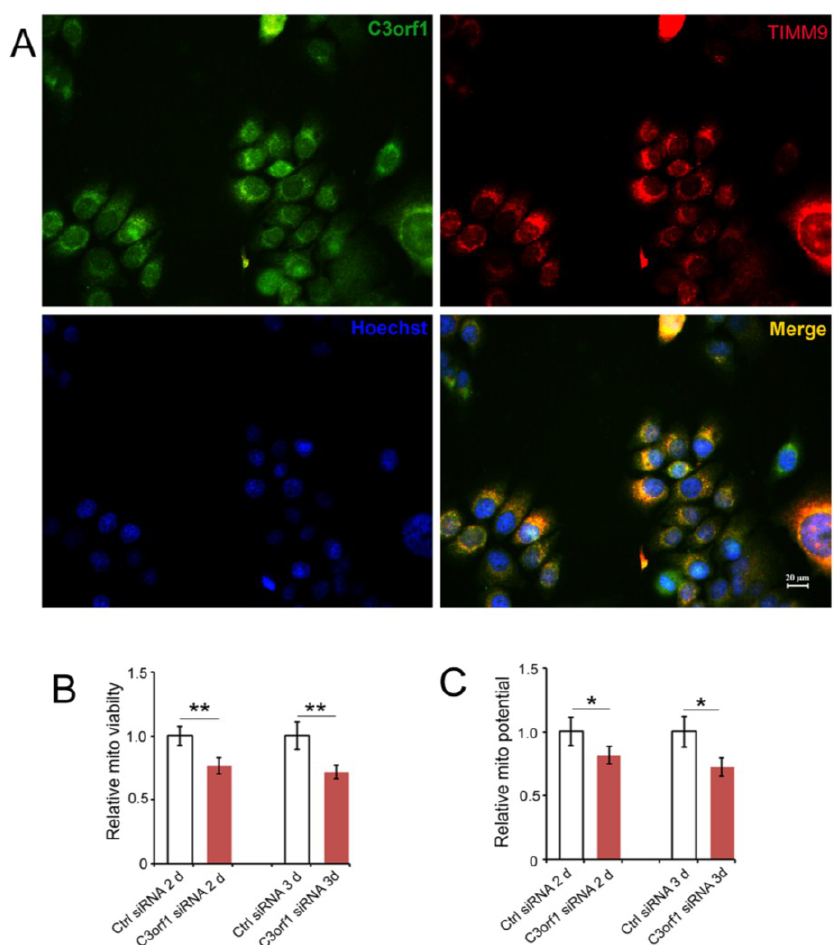
Figure 3. C3orf1 localizes to the inner mitochondrial membrane of 95D cells and C3orf1 knockdown affects mitochondria-related functions; ( A ) Representative images of immunostaining with anti-C3orf1 antibody (in green) and anti-Timm9 antibody (in red). The nucleus was labeled with Hoechst33342 dye (in blue). Scales bar = 20 µm; ( B ) Results of mitochondrial viability assays on 95D cells subjected to control or c3orf1 siRNA treatment for 2 days (2d) and 3 days (3d). Data are represented as mean ± SD. The data were normalized as described above, and the average mitochondrial viability of 95D cells treated with ctrl siRNA was set to 1; ** p < 0.01, n = 3; ( C ) Results of mitochondrial potential assays on 95D cells subjected to control or c3orf1 siRNA treatment for 2 days (2d) and 3 days (3d). Data are represented as mean ± SD. The data were normalized, and the average mitochondrial potential of 95D cells treated with ctrl siRNA was set to 1; * p < 0.05, n = 3; ( D ) Results of mitochondrial number assays in 95D cells subjected to control or c3orf1 siRNA treatment for 2 days (2d) and 3 days (3d). Data are represented as mean ± SD. The data were normalized, and the average mitochondrial number of 95D cells treated with ctrl siRNA was set to 1; n = 3; ns = no significant change in mitochondrial numbers between cells treated with control siRNA or c3orf1 siRNA; and ( E ) Results of ATPase activity assays on 95D cells subjected to control or c3orf1 siRNA treatment for 2 days (2d) and 3 days (3d). Data are represented as mean ± SD. The data were normalized, and the average ATPase activity of 95D cells treated with ctrl siRNA was set to 1; * p < 0.05, ** p < 0.01, n =